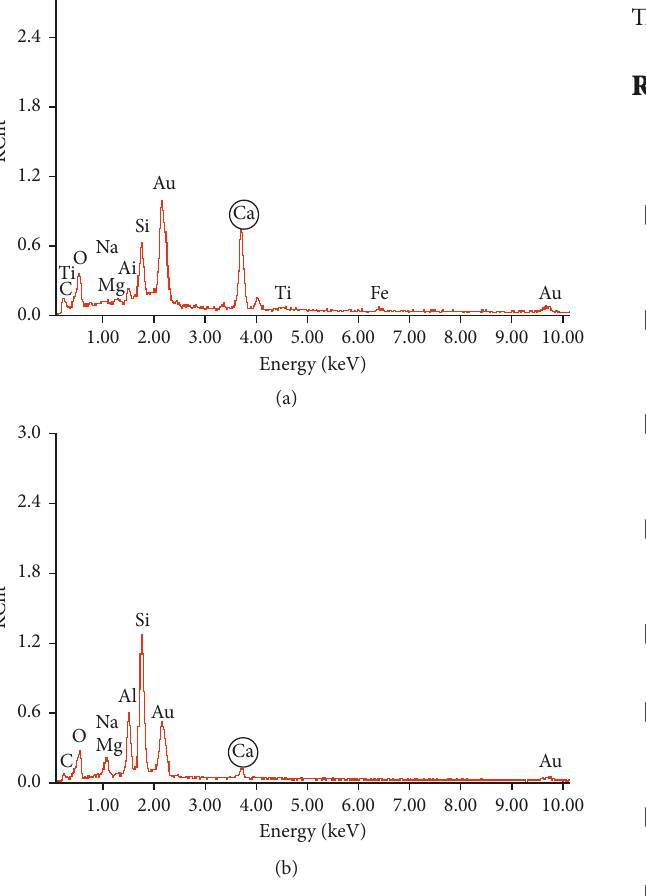
Figure 11: Comparison of distribution of elements in microscopic regions of concrete without and with nano-SiO 2 : (a) distribution of elements in the microscopic region of concrete without nano-SiO 2 ; (b) distribution of elements in the microscopic region of concrete with nano-SiO 2